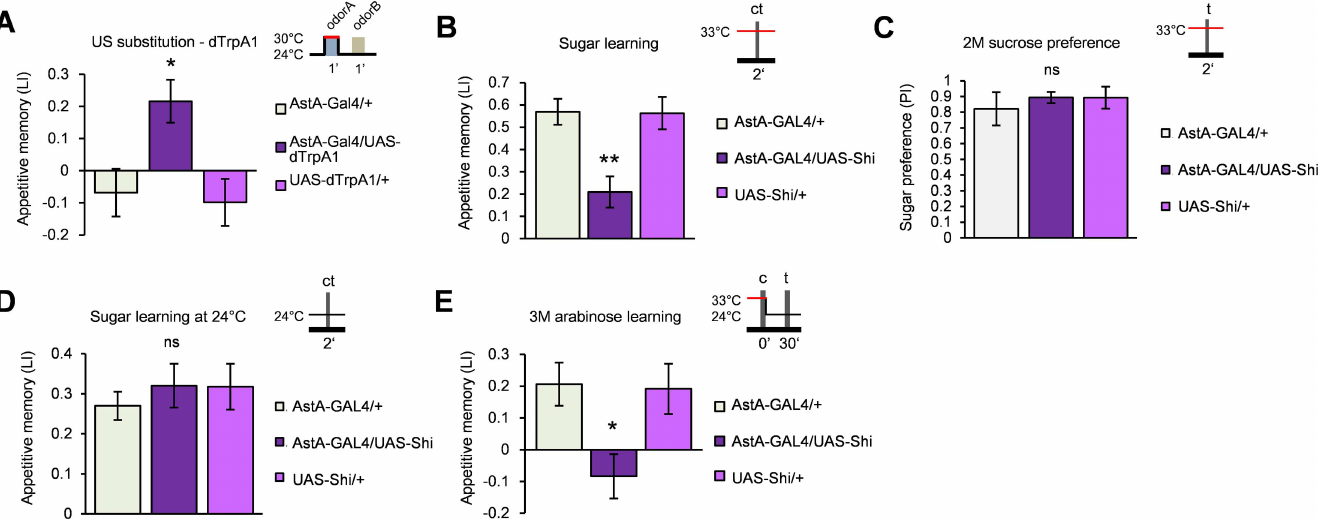
Fig 6. Allatostatin A neurons mediate reward. (A) Thermoactivation of AstA -expressing neuronsusing UAS-dTrpA1 inducesimmediateappetitive memory. n = 16. (B–C) Blockadeof the AstA neurons with UAS-shi ts1 impairs immediateappetitivememory (B, n = 8) whileleavingsucrose preference intact (C, n = 6–8). (D) Normal learningperformanceof AstA-GAL4/UAS-Shi ts1 flies at a permissivetemperature. n = 6–8. (E) Blockadeof the AstA neuronswith UAS-shi ts1 duringlearningimpairs immediateappetitivememory of nonnutritive sugar arabinose. n = 9–16. ns, not significant, * p < 0.05, ** p <